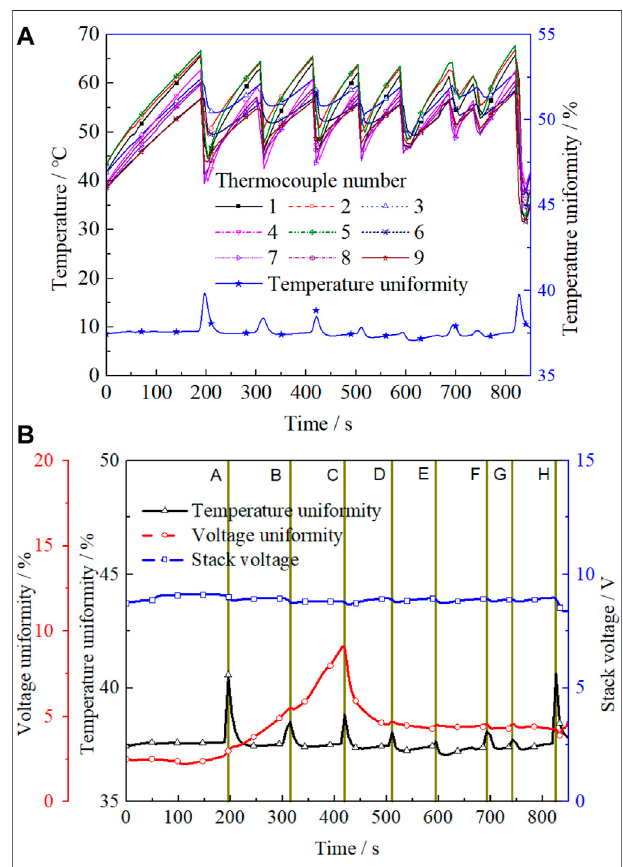
FIGURE 9 | Effect of condensing fan on-off operation. (A) Temperature and temperature uniformity, (B) Stack voltage, voltage uniformity and temperature